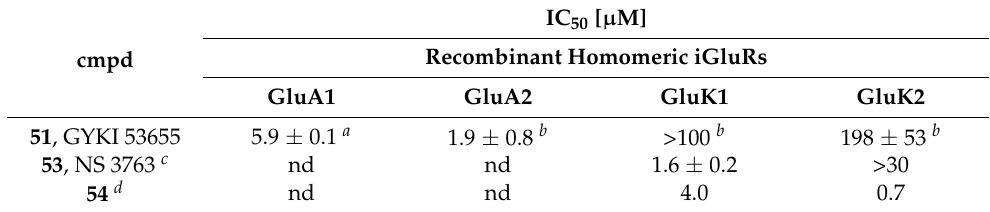
Table 8. Functional data for non-competitive antagonists of kainate receptors (all values in µ M).